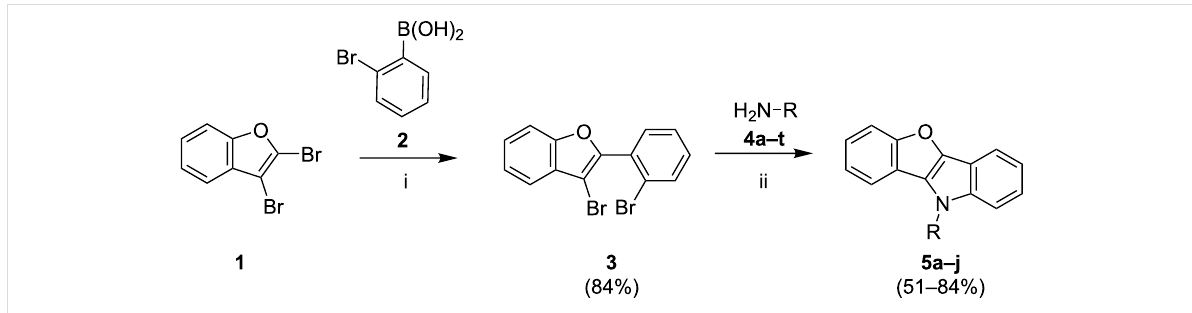
Scheme 1: Synthesis of benzo[4,5]furo[3,2- b ]indoles 5a–j . Conditions: (i) 1.2 equiv 2-bromophenylboronic acid ( 2 ), 5 mol % Pd(PPh 3 ) 4 , 3.0 equiv